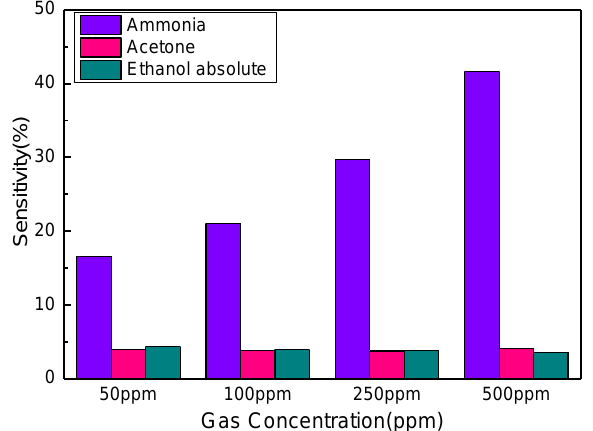
Figure 10. Bar chart of selectivity test for the UVO 1-min sample sensor.